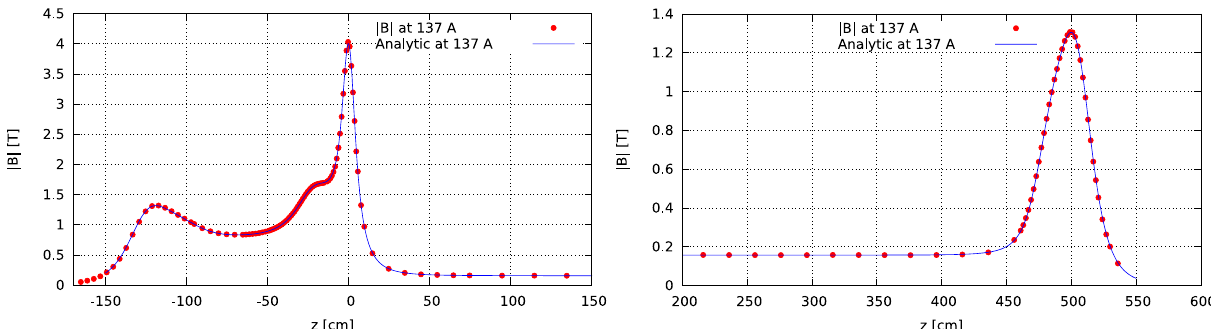
Figure 4. Magnetic field on-axis measured during acceptance testing at the SNS (data in red, prediction in blue). The result agrees with prediction at the level of precision of this preliminary measurement. Table 1. Updated table of systematics from references [3,30,31]. The (*) indicates a fit parameter. Small in the third column indicates ( (cid:8) a / a ) SYST < 1 × − 4